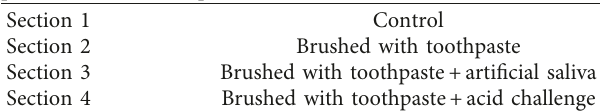
Table 2: Test and control discs with the specific method of ap- plication of the toothpaste